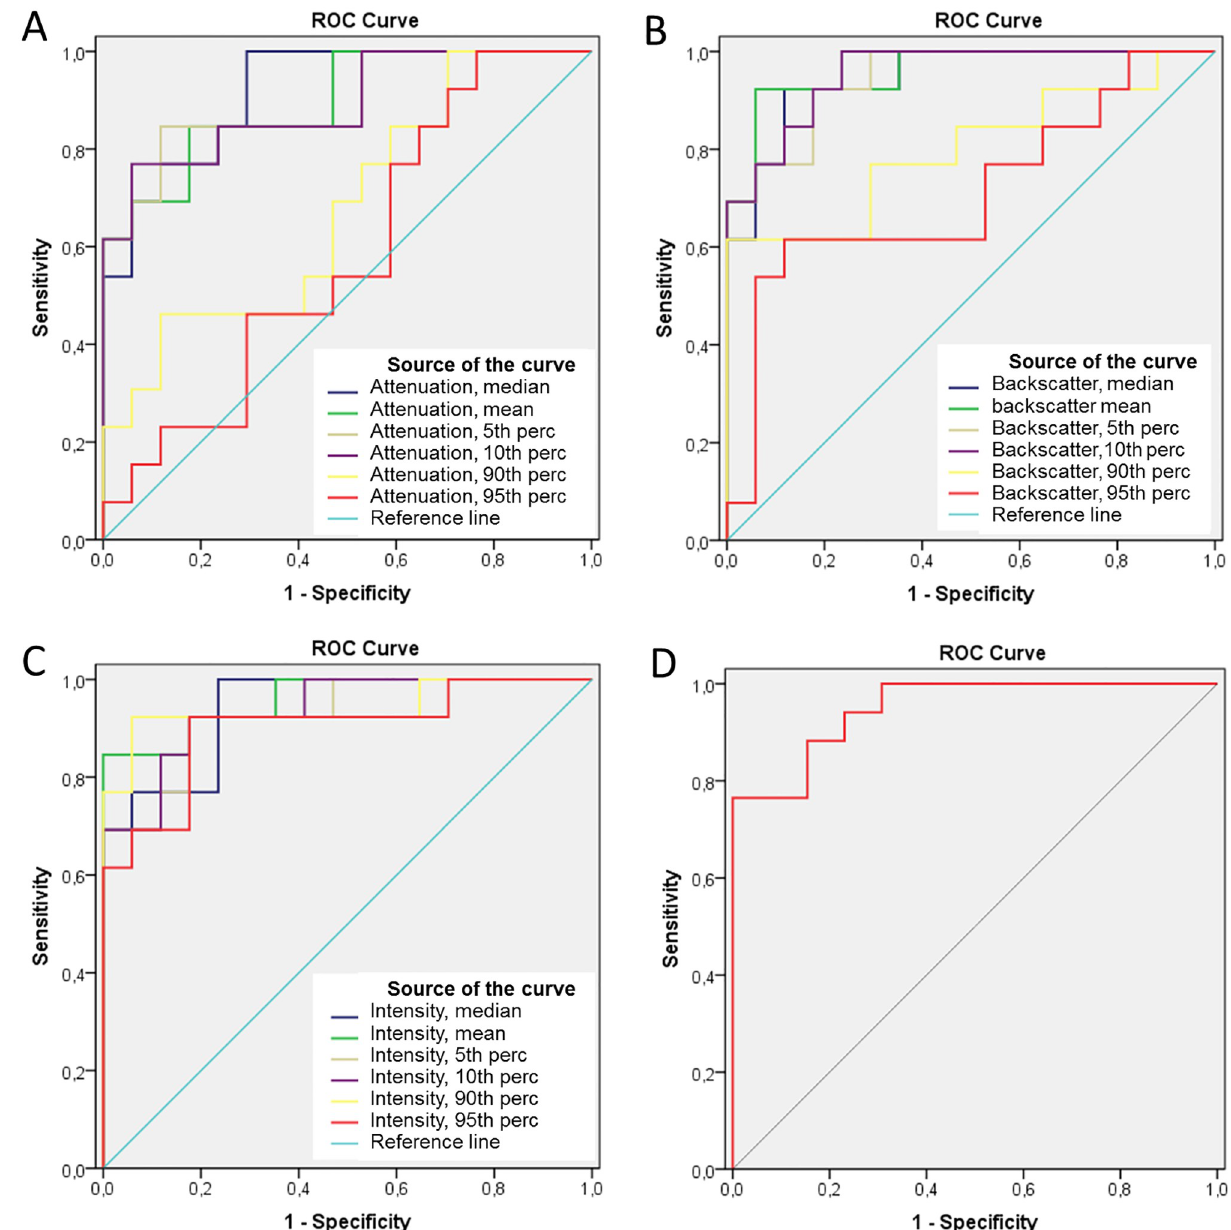
Fig 4. Receiver operating characteristic (ROC) curves of parameters determined by QCU-CMS software in prediction of thrombus type (white vs. red). Different statistical parameters of attenuation (A), backscatter (B), grayscale intensity (C) and the ratio of 95 th percentile of attenuation and median grayscale intensity (D). Perc,